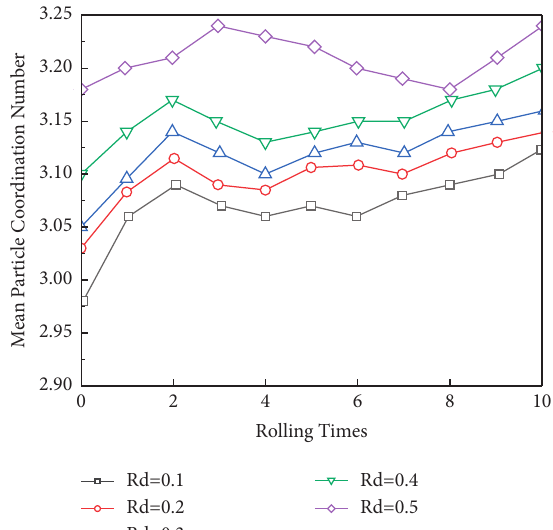
Figure 18: Mean particle coordination number-compactor pass responses for fillings with different